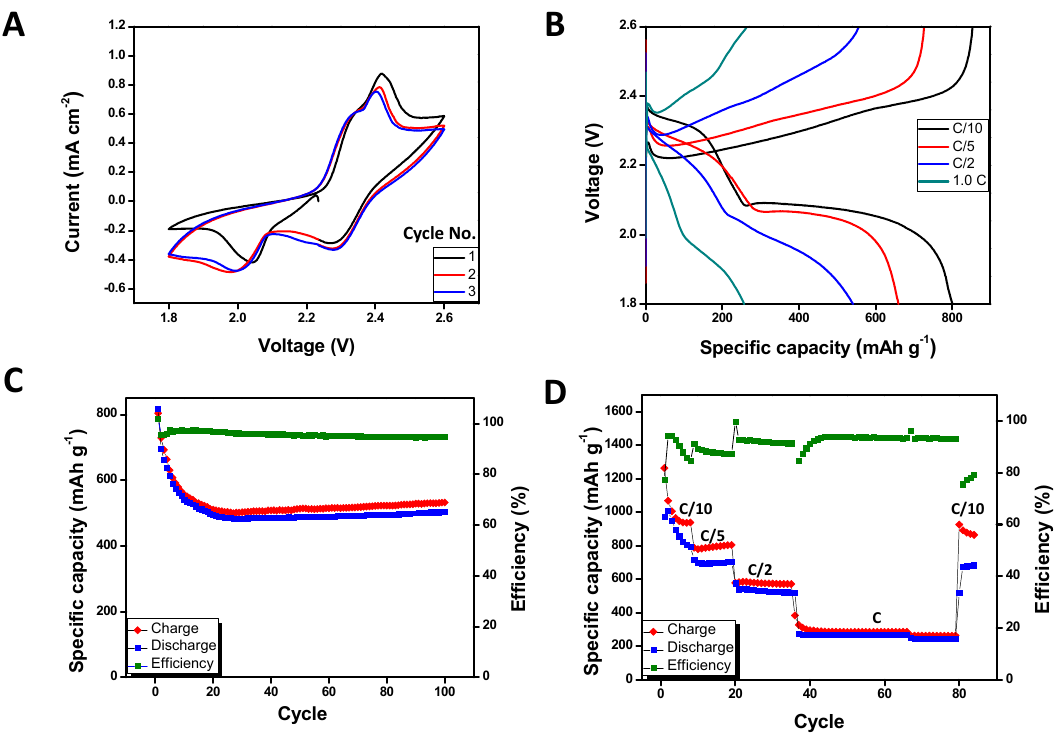
Figure 6. Electrochemical characterizations of graphene-sulfur composite (GS2) as Li-S cathode materials. ( A ) Cyclic voltammetry of first three cycles of the graphene-sulfur composite (GS2) at 0.2 mV · s − 1 in a potential window from 1.8 to 2.6 V vs. Li/Li + ; ( B ) Charge/discharge curve of graphene-sulfur composite GS2 at the various charge rates at the 10th cycle; ( C ) Long-term cycling performance of graphene-sulfur composite GS2 at rate of C/2; ( D ) Specific capacity at different current rates of the graphene-sulfur composite GS2.